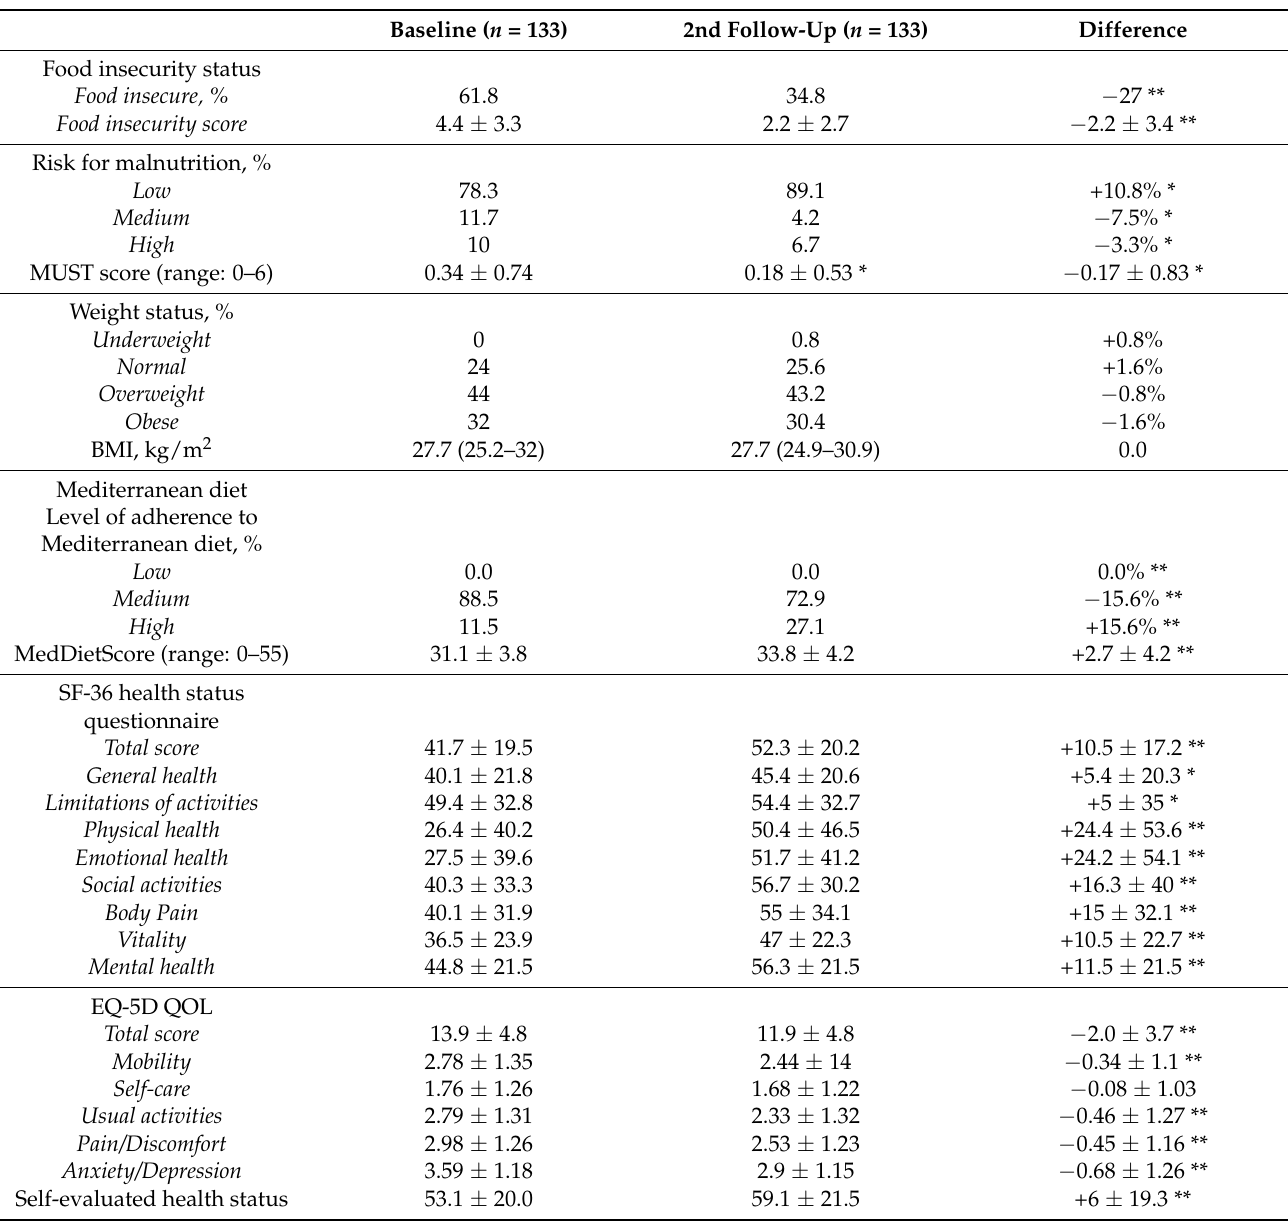
Table 2. Food insecurity, risk for malnutrition, BMI, adherence to the Mediterranean diet, quality of life, and health status at baseline and 2nd follow-up. Baseline ( n = 133) 2nd Follow-Up ( n =